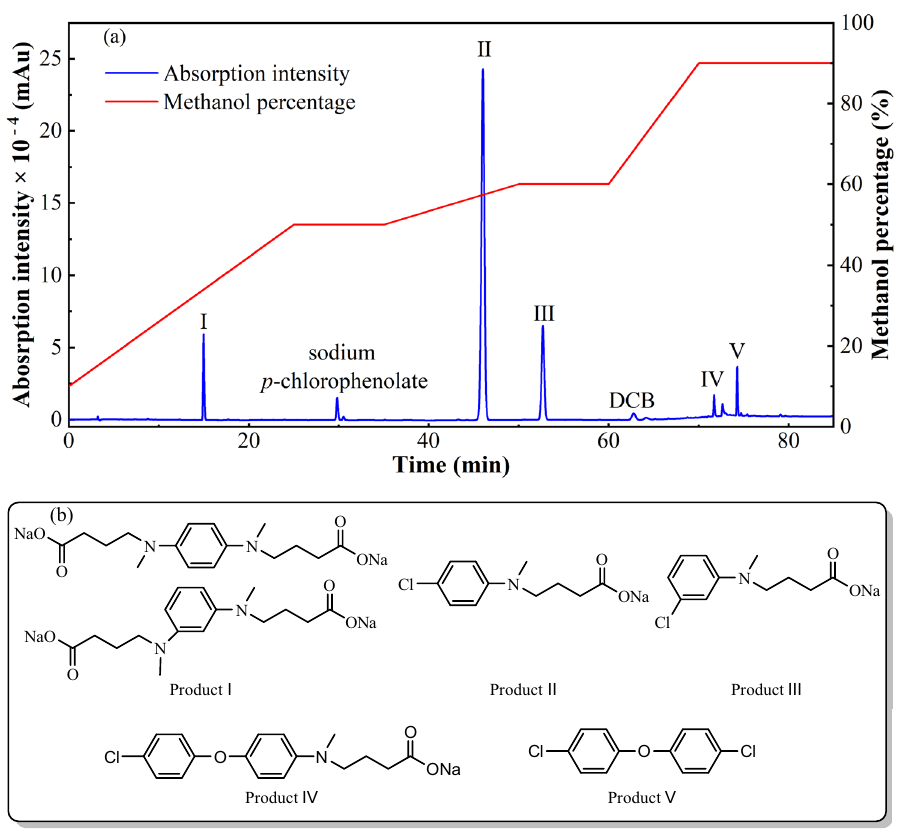
Figure 2: The gradient elution curve and chromatogram of the reaction products of DCB with ( a ) SMAB; the molecular structure of ( b ) products I, II, III, IV, and V.